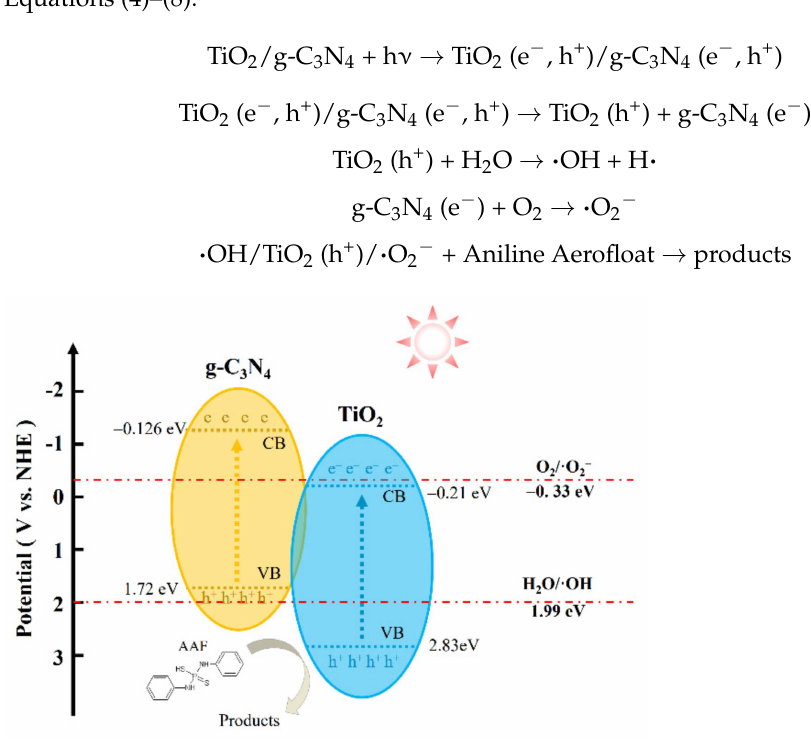
Figure 10. The possible photodegradation mechanism process of TiO 2 /g-C 3 N 4